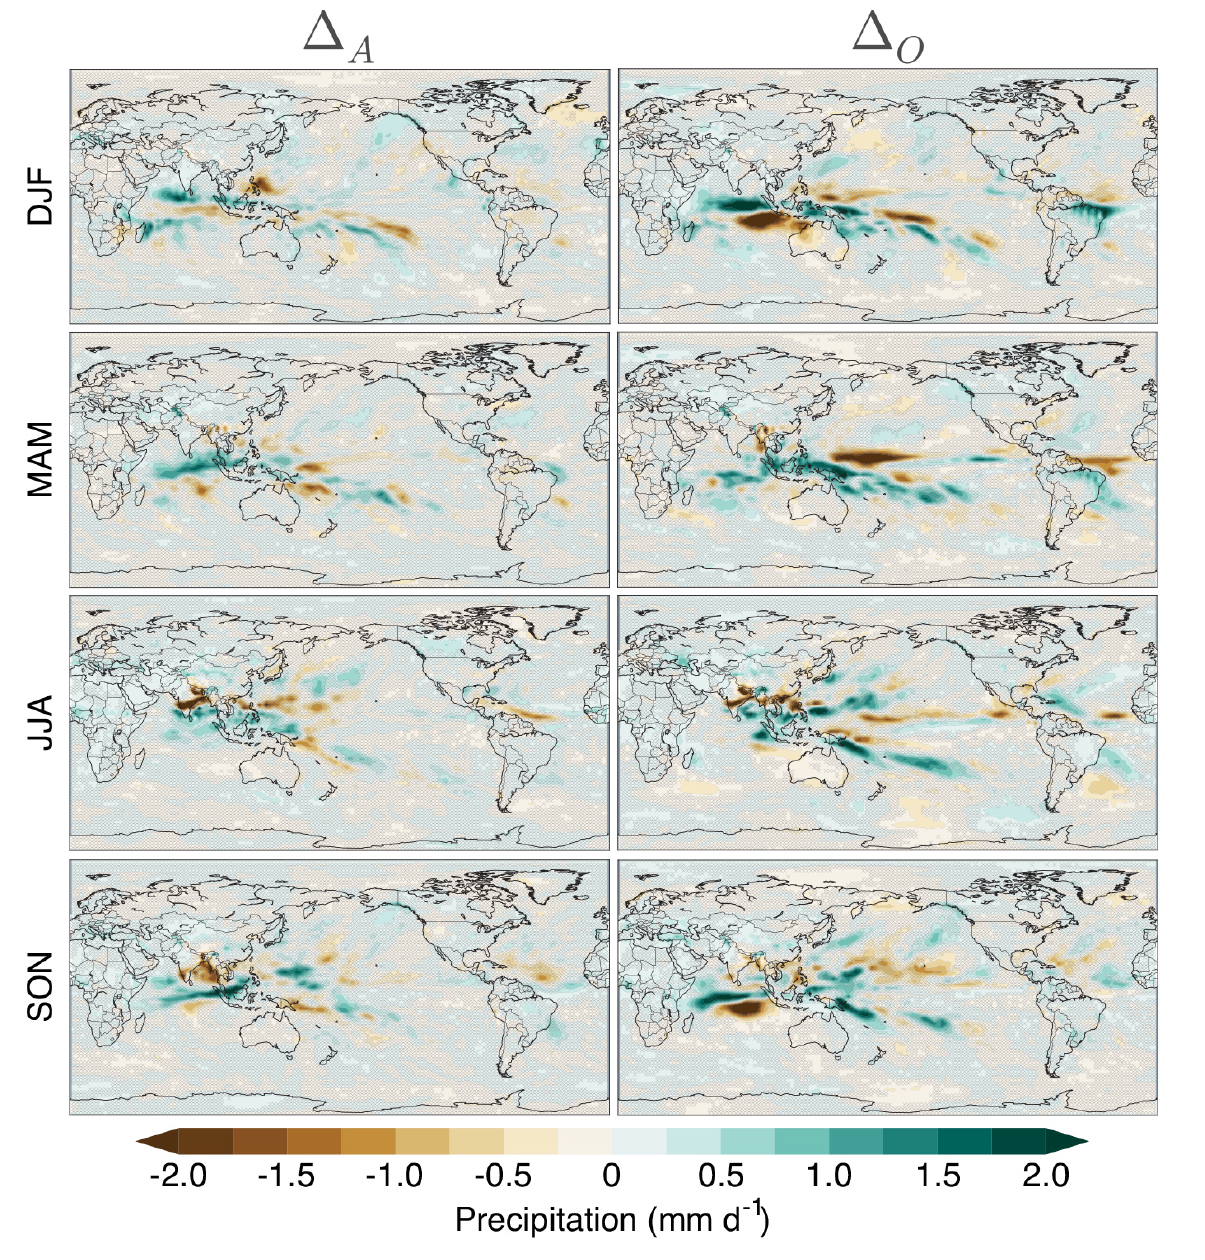
Figure 7. Same as Fig. 3 but for precipitation differences (mmday − 1